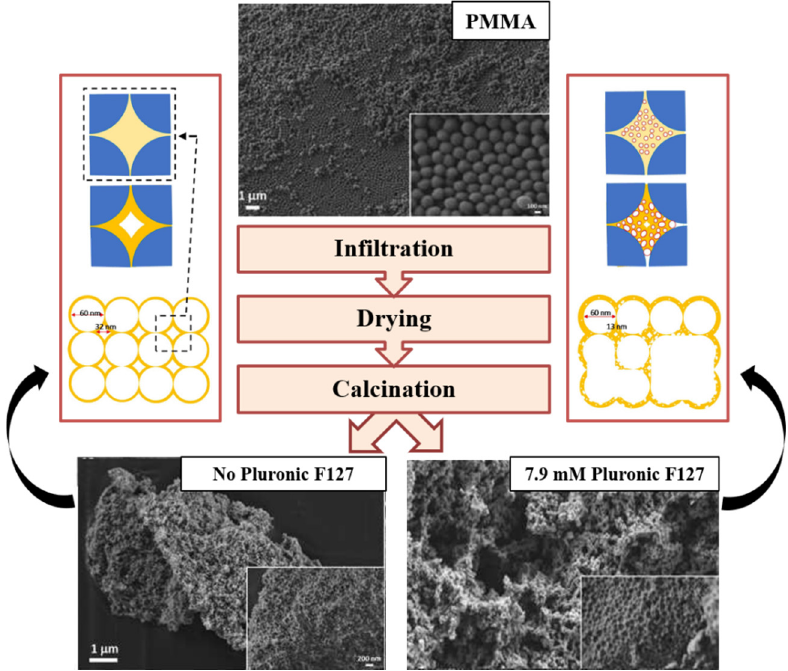
Figure 5. FESEM images of 3DOM catalysts prepared with PMMA hard template with or without the addition of Pluronic F127 (adapted from [65]).